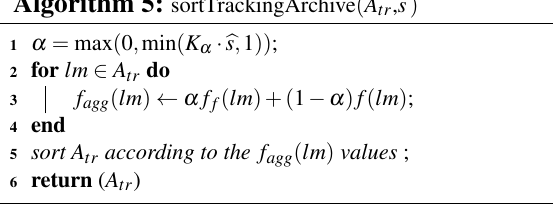
Algorithm 5: sortTrackingArchive ( A